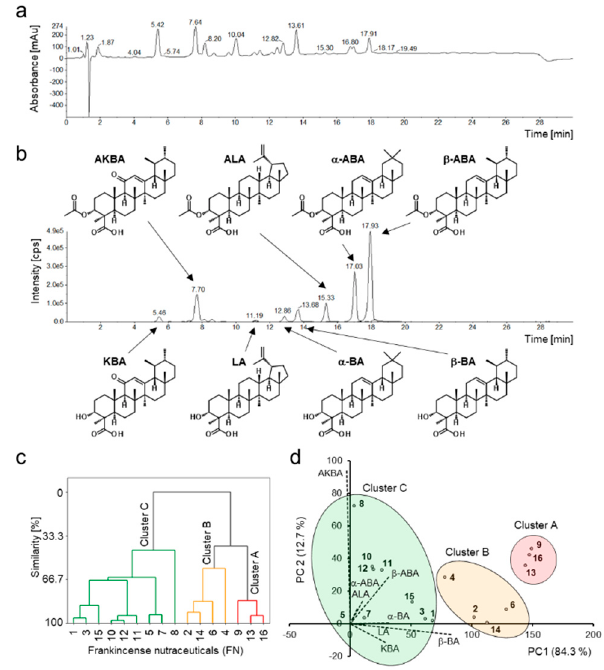
Figure 2. Chromatograms of HPLC-DAD-MS/MS analysis of sample FN9 and multivariate statistical analysis of BAs and LAs contents in different FNs. ( a ) Total wavelength chromatogram with detection at 210 nm, 254 nm, and 280 nm. ( b ) Multiple-reaction monitoring chromatogram and structures of BAs and LAs present in FNs. ( c ) The dendrogram shows FNs assigned to three different clusters according to their BAs and LAs composition: Cluster A > 30%, Cluster B with 15–30%, and Cluster C < 15% of total BAs and LAs. ( d ) Samples within clusters exhibit similarity in their individual BAs and LAs compositions. Biplot of principal component analysis is shown. Sample FN8 shows the highest deviation due to its unusually high AKBA content concomitantly with very low levels of all other BAs and LAs. Numbered scores visualize the individual FN1-16 in the biplot and dashed lines demonstrating the loadings of the individual BAs and